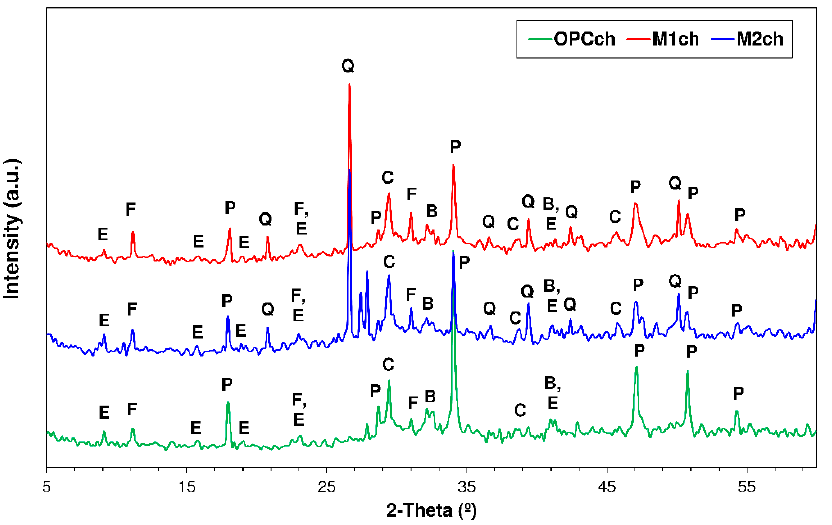
Figure 6. XRD patterns for 56-d OPC, M1 and M2 exposed to 0.5 M NaCl (Note—E: ettringite; F: Friedel’s salt; P: portlandite; Q: quartz; O: orthoclase; A: Albite; C: calcite; and B: belite).